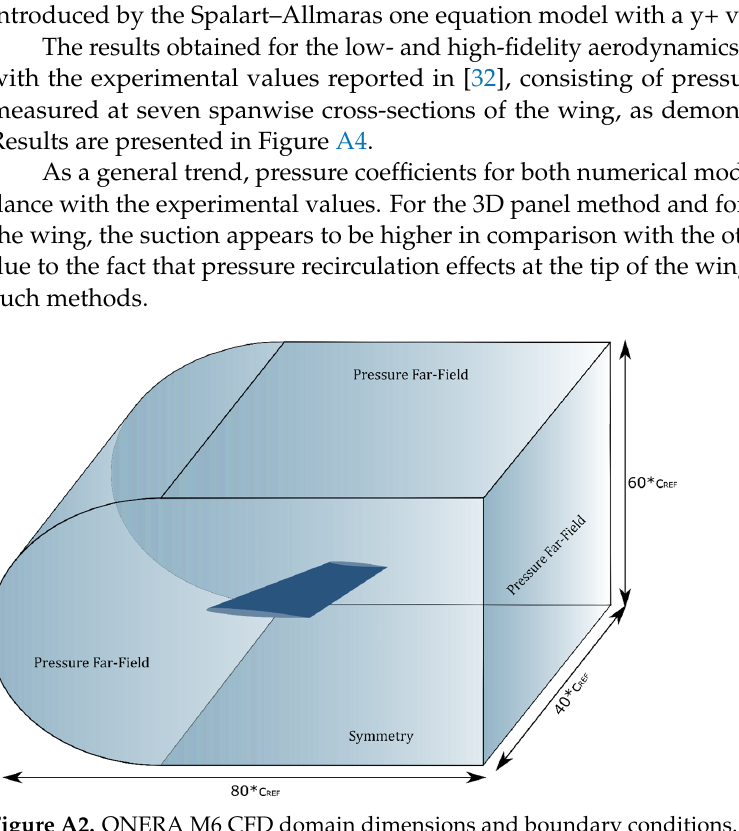
Figure A2. ONERA M6 CFD domain dimensions and boundary